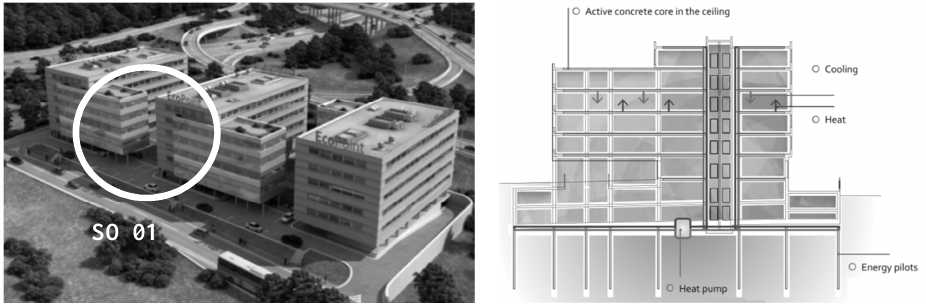
Figure 4 – EcoPoint Office Center Košice (www.ecopoint.sk